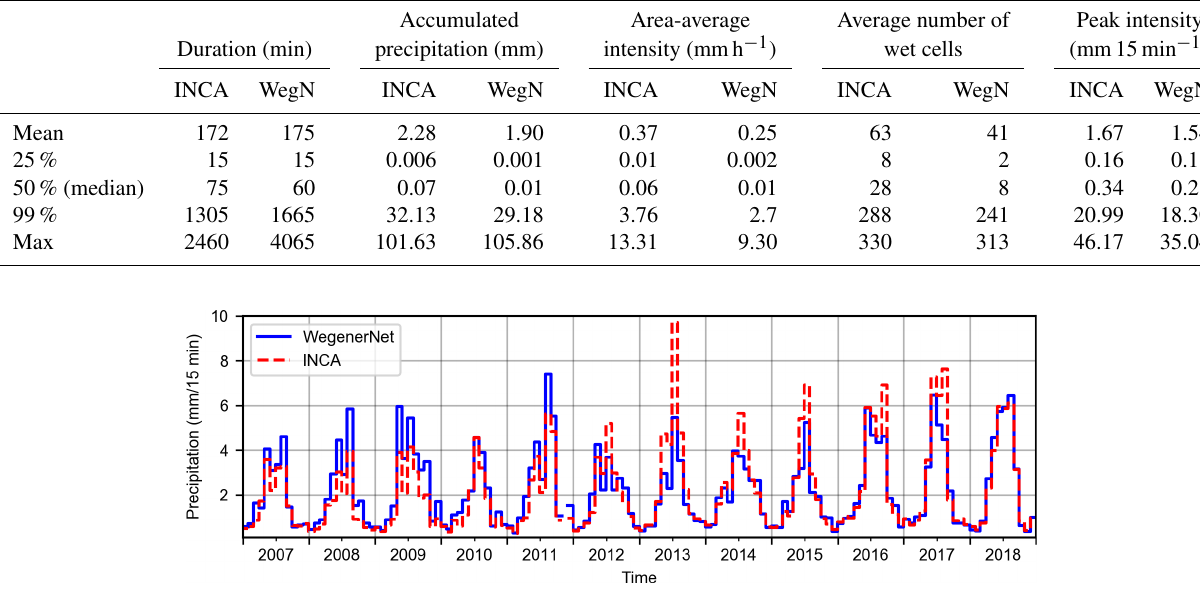
Figure 10. Monthly mean of the peak (mm per 15min) for each event for WegenerNet and INCA.